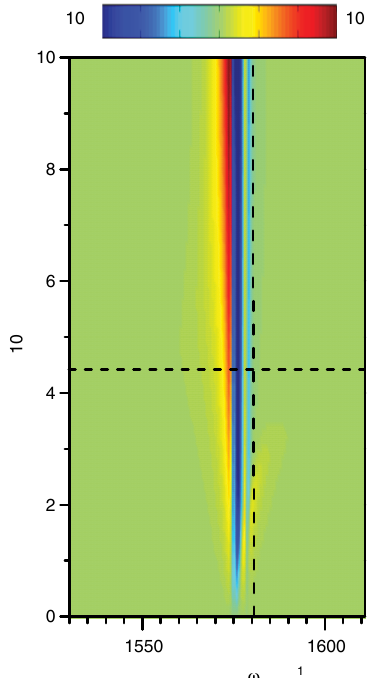
Figure 9 Slow light effect in bilayer graphene plasmonic devices. The figure shows the 2-dimensional map of the light group index as a function of frequency and plasmon wavevector (adapted with permission from [56], Copyright 2014 American Chemical